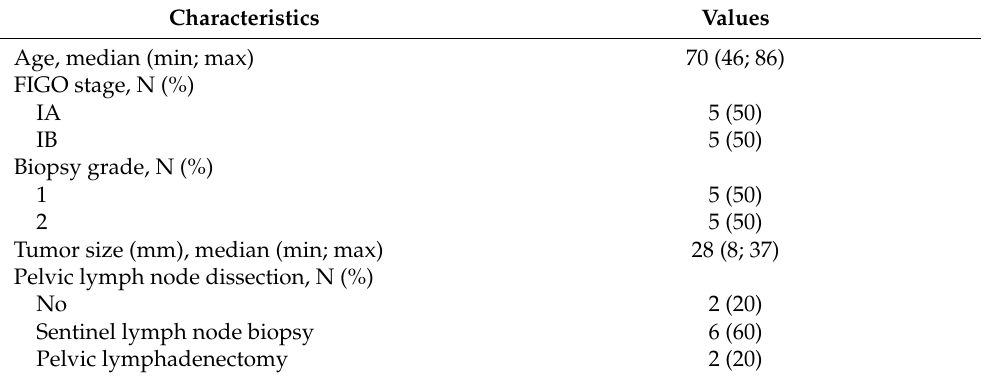
Abbreviations: SD, standard deviation; FIGO, Federation of Gynecology and